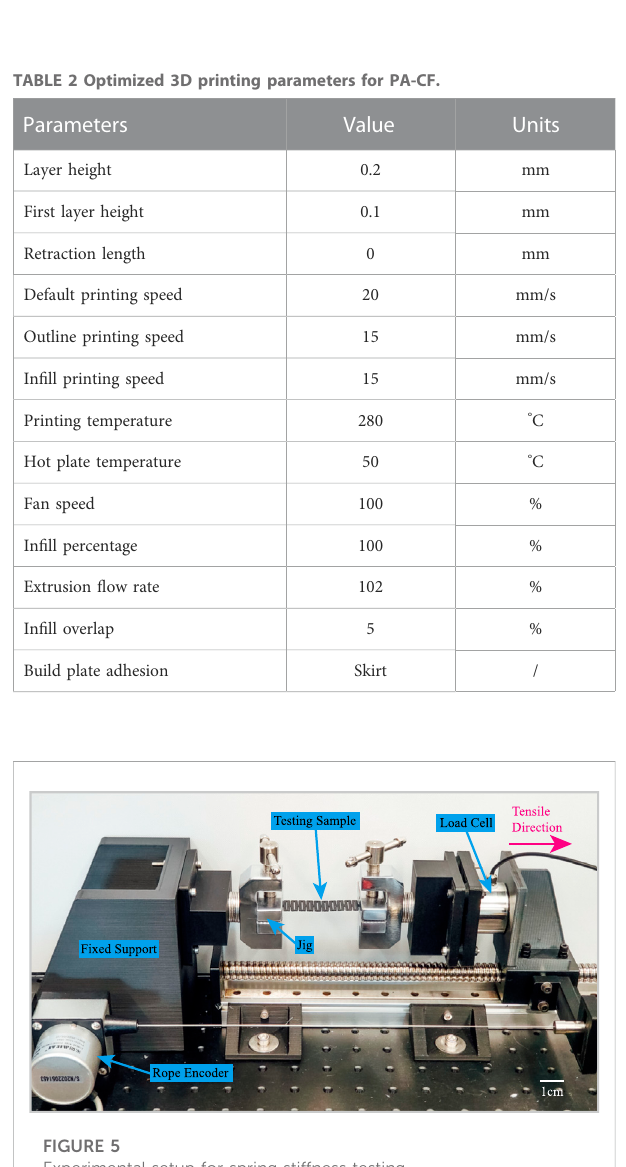
Table 1. The maximum deformation ratio λ max could be